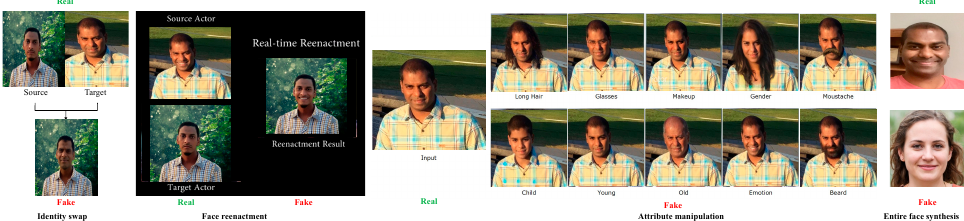
Figure 2. Real and fake examples of each deepfake/face manipulation group. The fake sample in “Entire face synthesis” group is obtained from the method in [81].